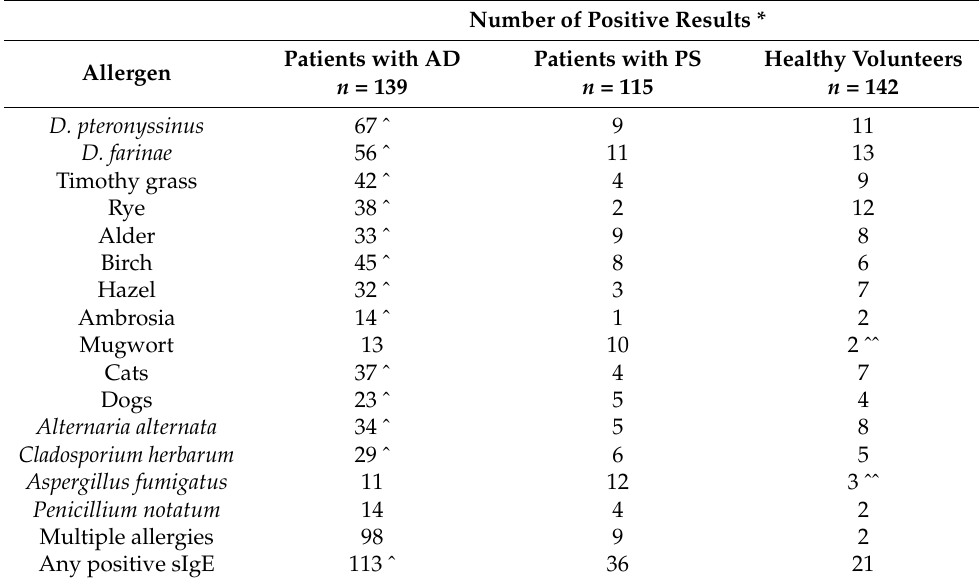
Table 2. Positive results of allergen-specific IgE for inhaled allergens in the studied